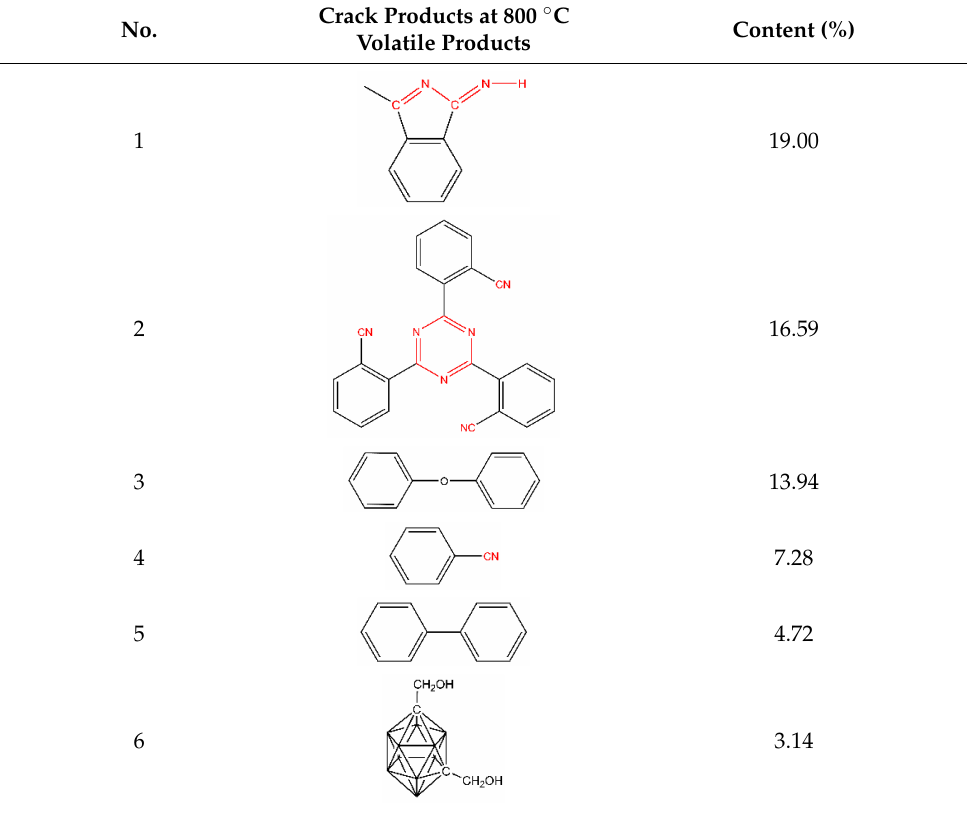
Table 3. Composition of BPh-Q 10 cracking products at 800 ◦